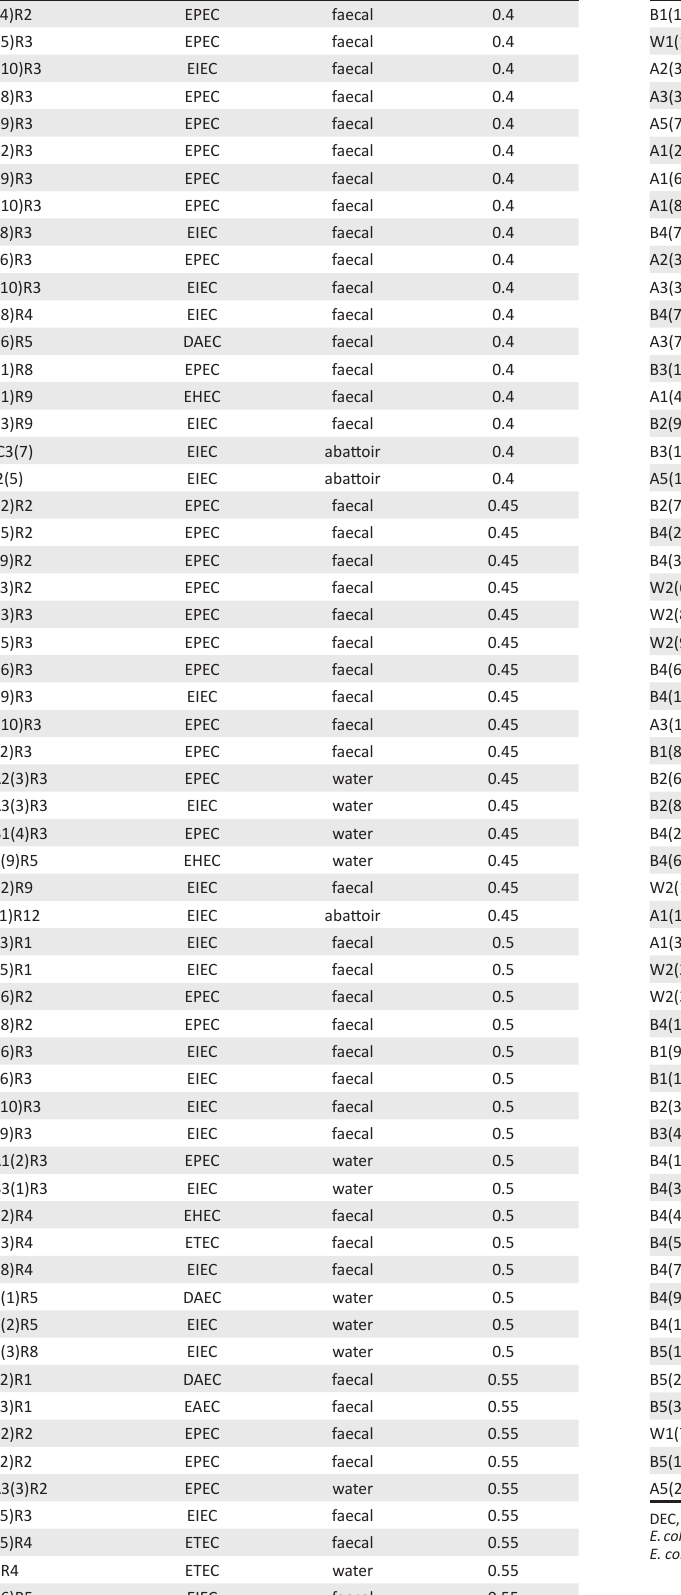
TABLE 4-A1 (Continues...): Multiple-antibiotic resistance index for all diarrheagenic E. coli pathotypes along the farm-to-fork continuum. Bacterial ID DEC pathotype